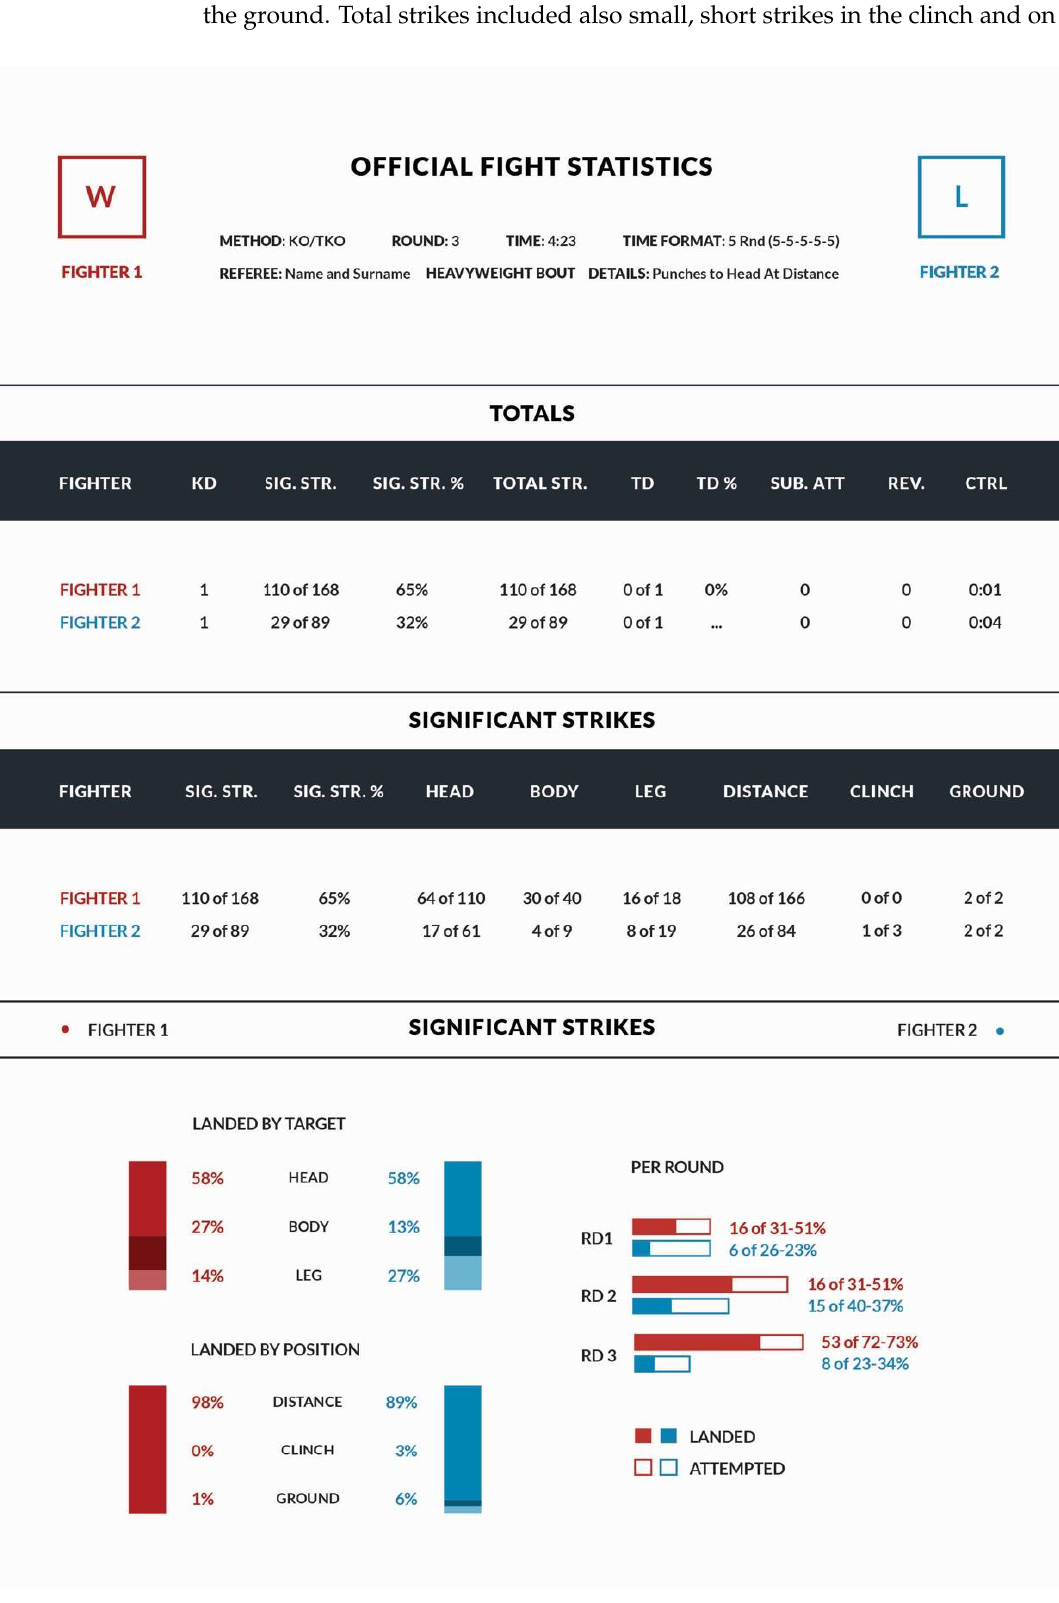
Figure 1. Schematic view of fight statistics used for database.